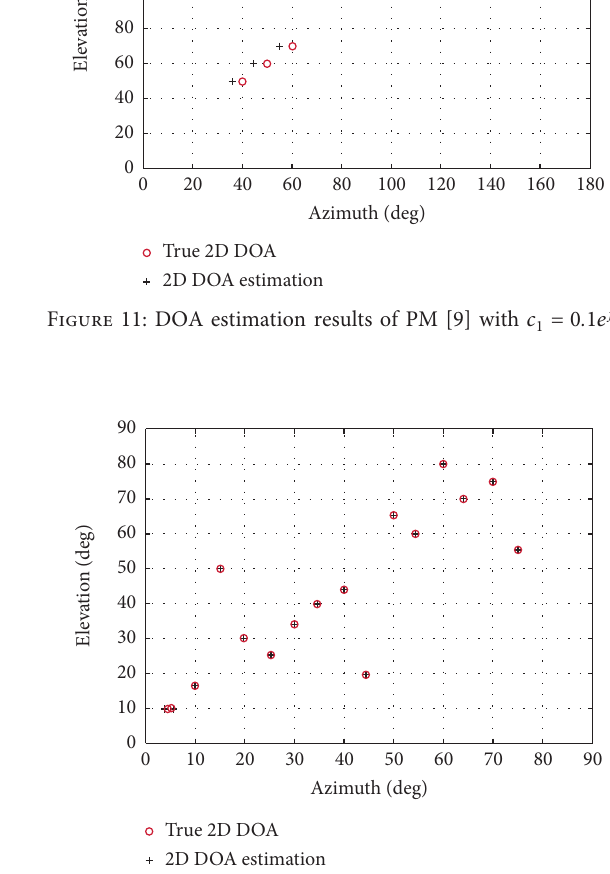
Figure 12: DOA estimation results of the proposed method for small interval